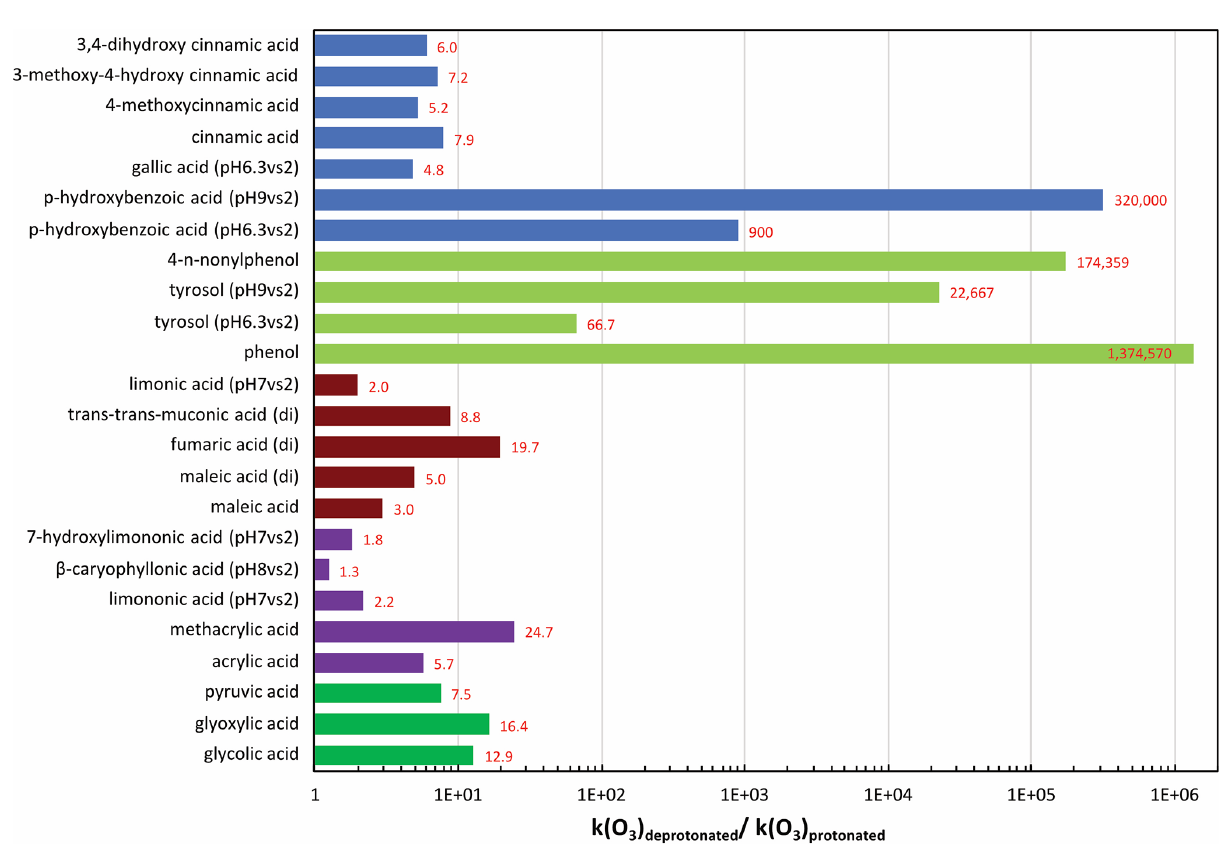
Figure 17. Calculated κ R ( O 3 ) of different dissociating organic compounds. The κ R ( O 3 ) ratio of the dianion and protonated diacid is indicated by the add-on, (di), behind the acid name. The applied aqueous-phase O 3 reaction rate constants are provided in Table S7 in the Supplement. Different colors indicate different compounds classes, such as substituted saturated monoacids (green), unsaturated monoacids (purple), unsaturated diacids (brown), phenols (light green), and aromatic acids